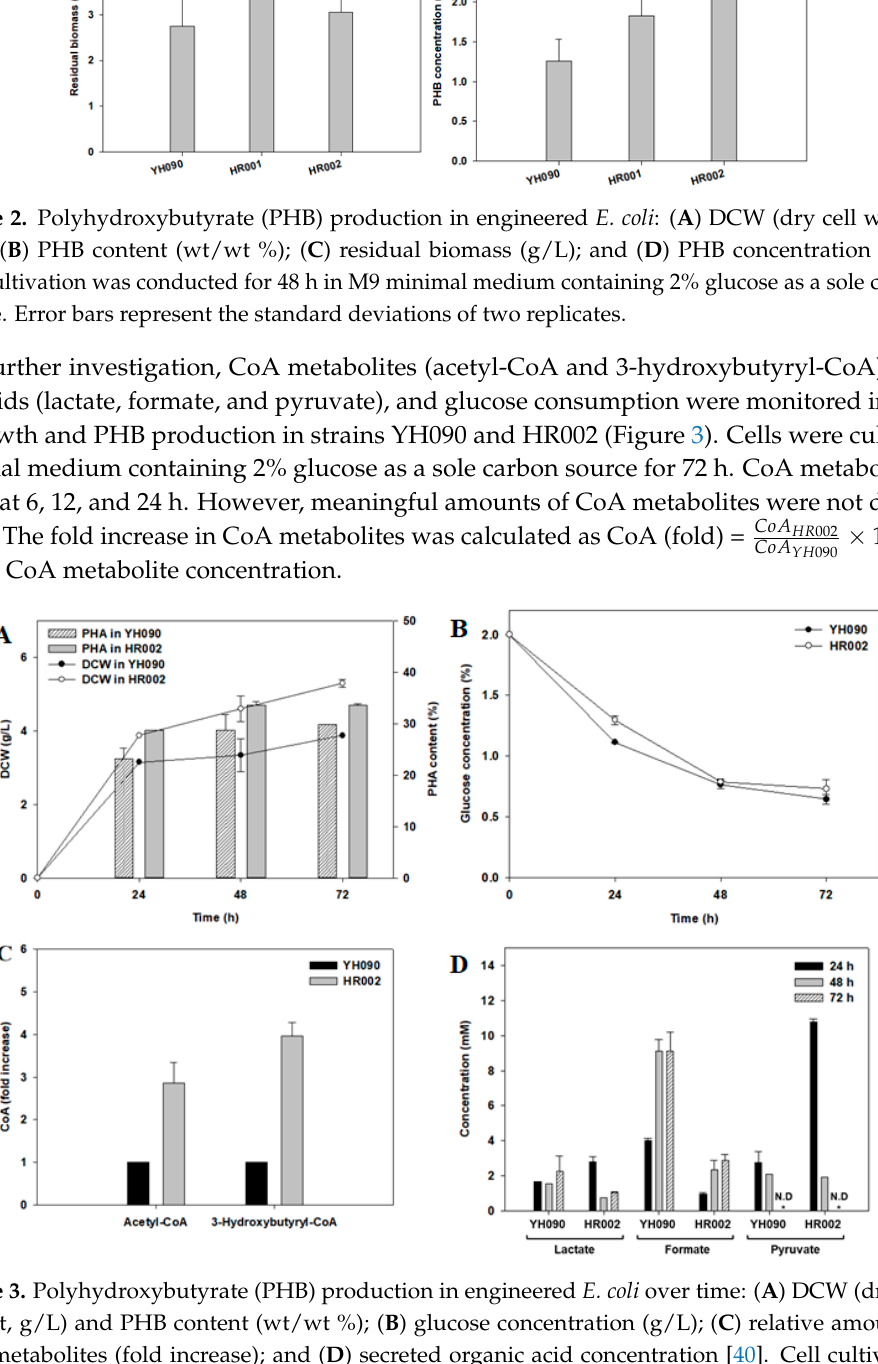
Figure 3. Polyhydroxybutyrate (PHB) production in engineered E. coli over time: ( A ) DCW (dry cell weight, g/L) and PHB content (wt/wt %); ( B ) glucose concentration (g/L); ( C ) relative amount of CoA metabolites (fold increase); and ( D ) secreted organic acid concentration [40]. Cell cultivation was conducted for 72 h in M9 minimal medium containing 2% glucose as a sole carbon source. CoA metabolites were measured at 6 h. Error bars represent the standard deviations of two replicates.